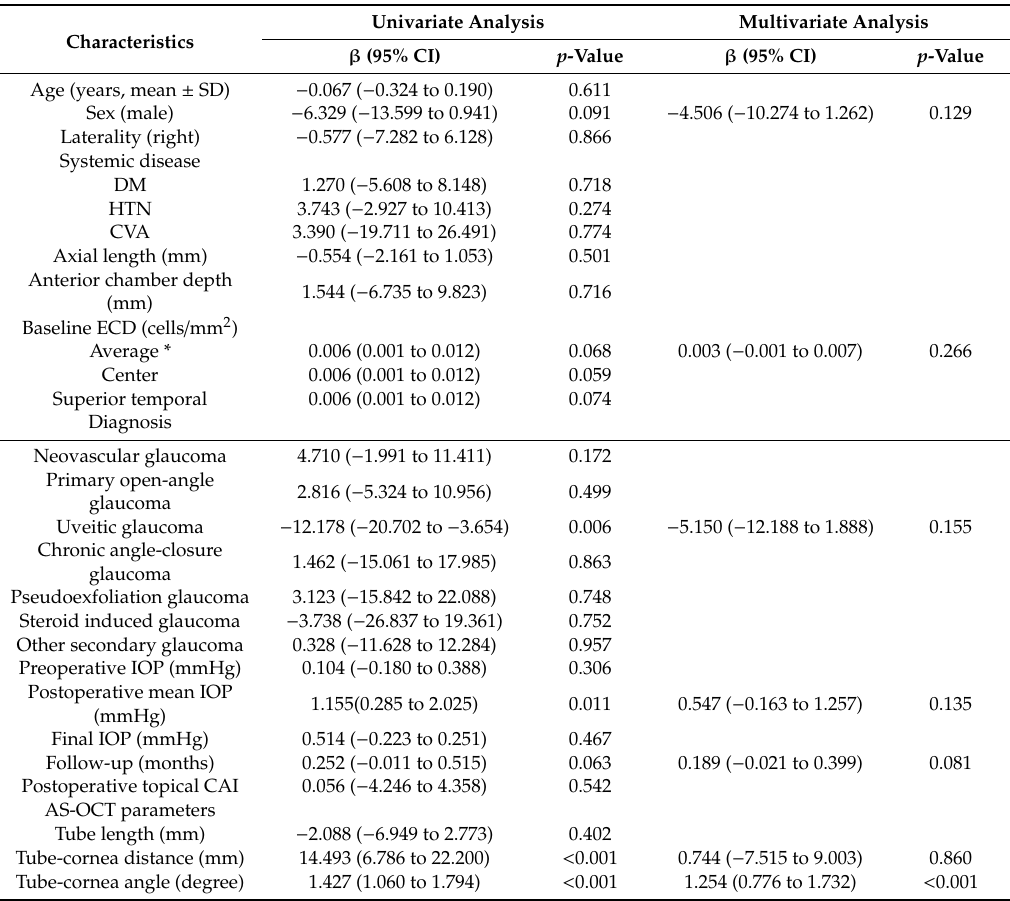
Table 4. Univariate and multivariate regression analyses of clinical variables associated with the rate of postoperative change in average corneal endothelial cell density (% / year)